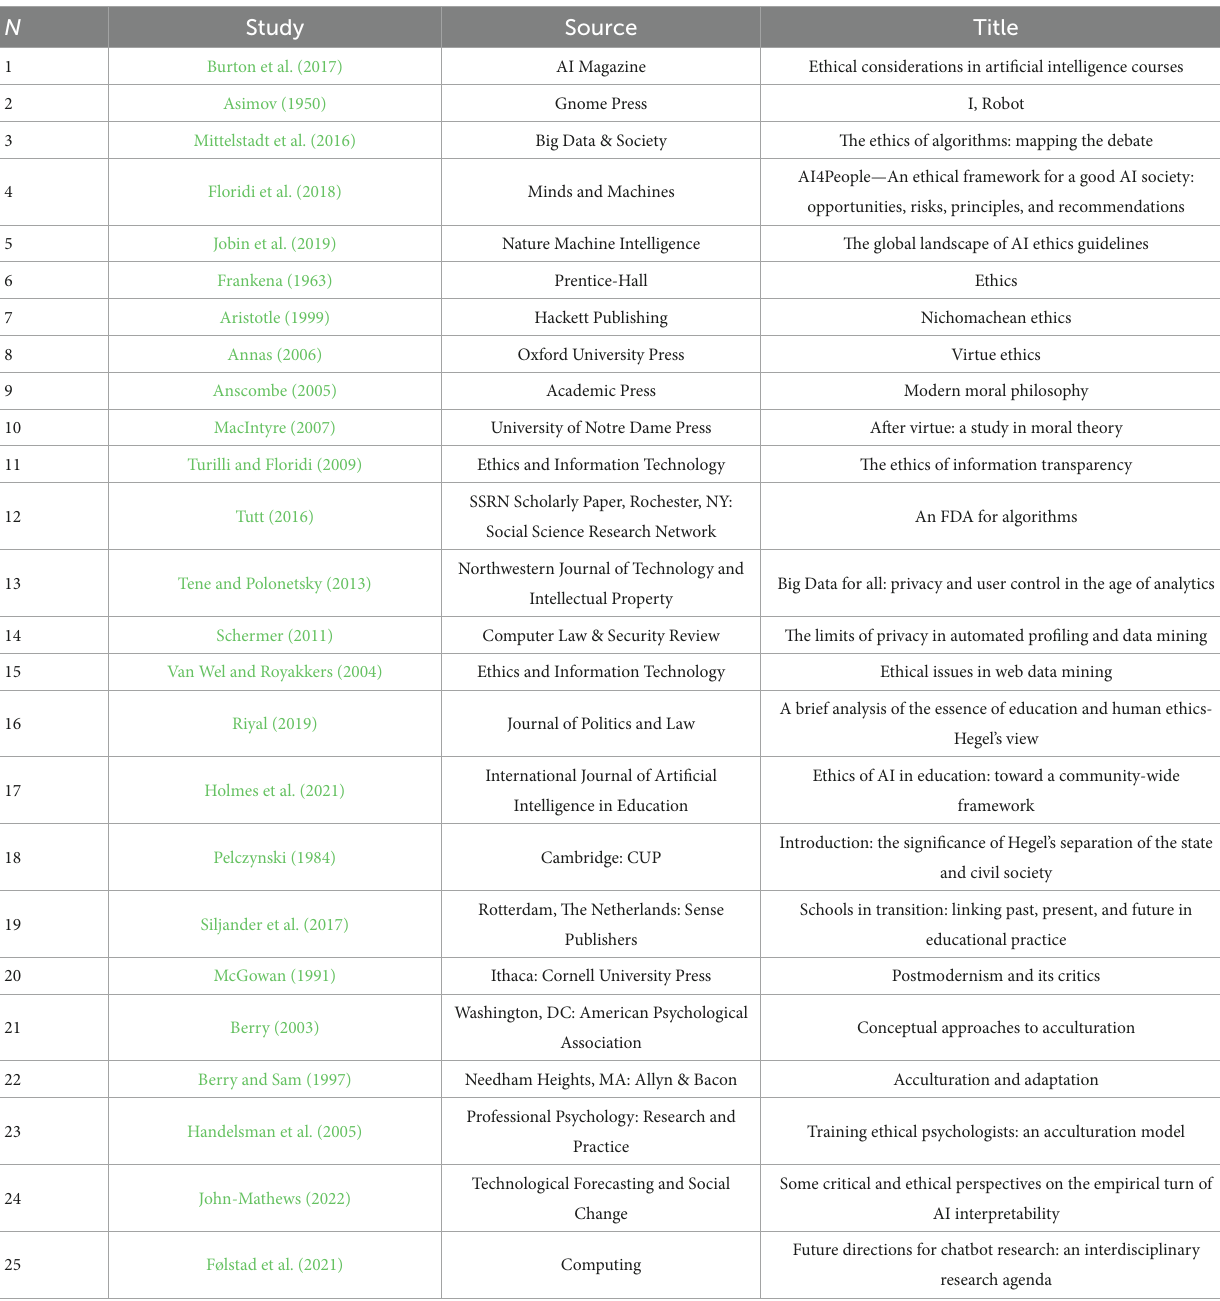
TABLE 1 Details of the included